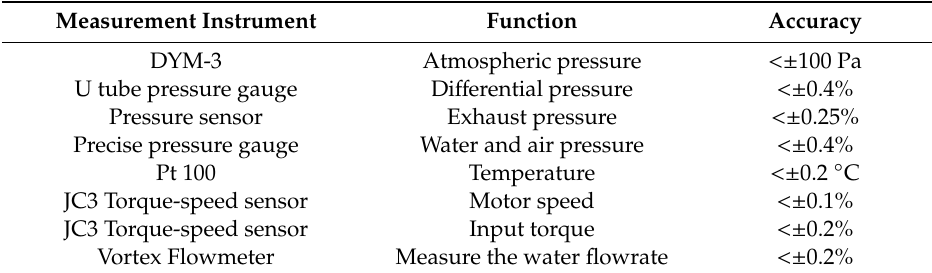
Table 2. The function and accuracy of the measurement